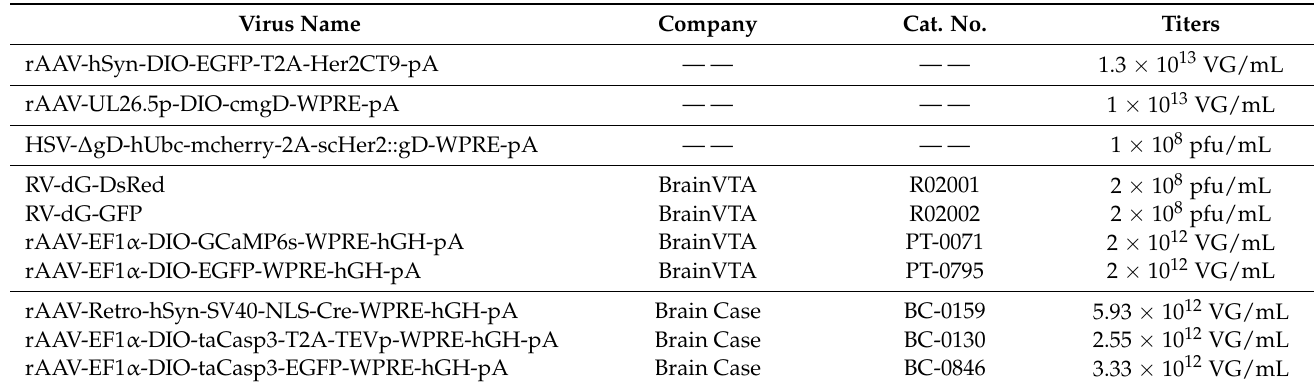
Table 1. Information of all the viruses listed in the